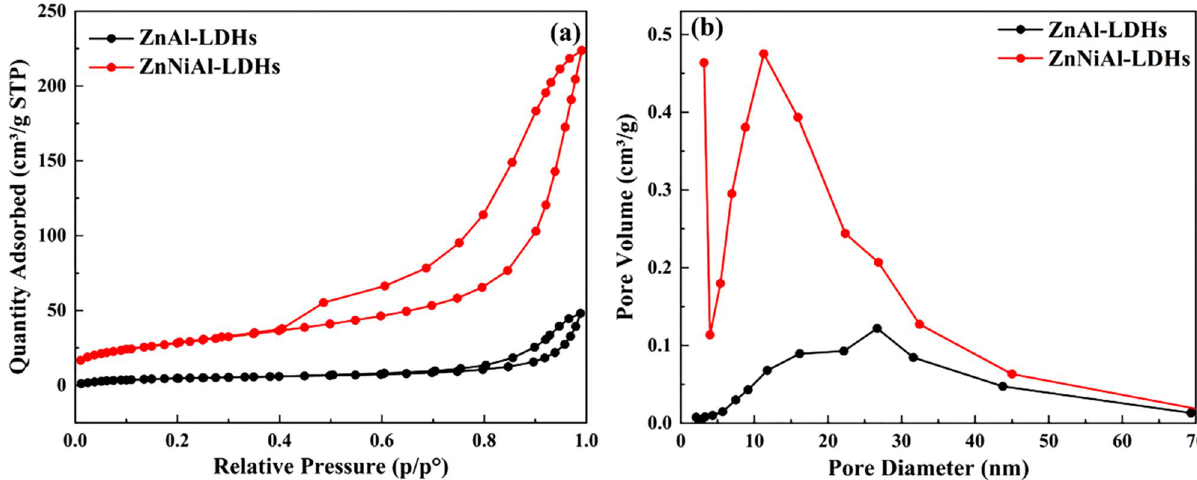
Figure 3. Nitrogen adsorption–desorption isotherms ( a ) and pore size distributions ( b ) of ZnAl-LDHs and ZnNiAl-LDHs.